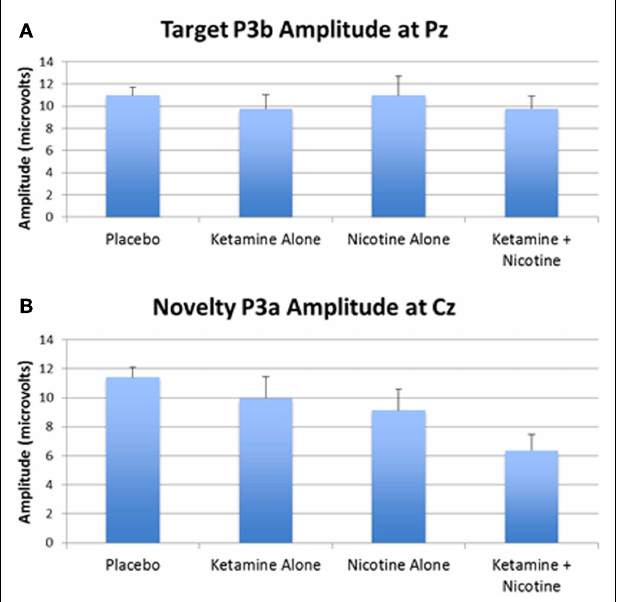
FIGURE 3 | Mean P300 amplitude across four test days . (A) Mean target P3b amplitude for each test day. (B) Mean novelty P3a amplitude for each test day. Error bars indicate standard